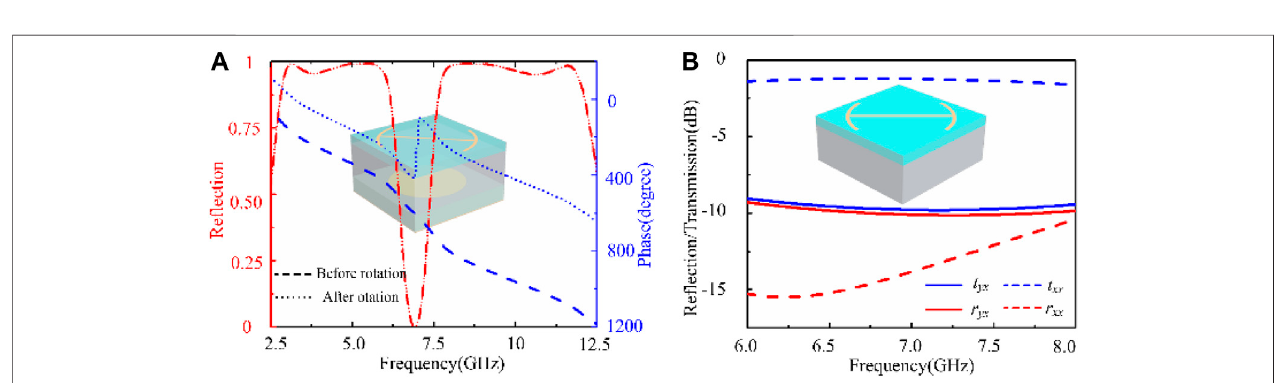
FIGURE 5 | (A) Re fl ection amplitude and phase change before and after rotation (The different lines represent the rotation before and after). (B) Re fl ection and transmission of the PC surface under the x -polarized wave.